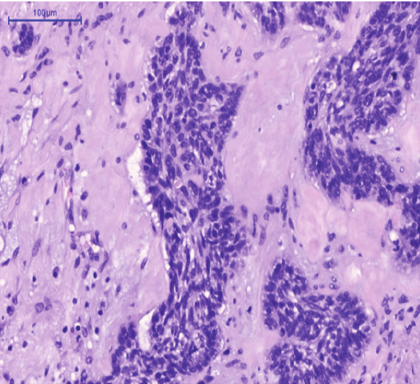
Figure 4: HE-staining. Hepatic bile duct with tumor cells in the lumen, and transition from metaplastic to dysplastic epithelium and invasion.